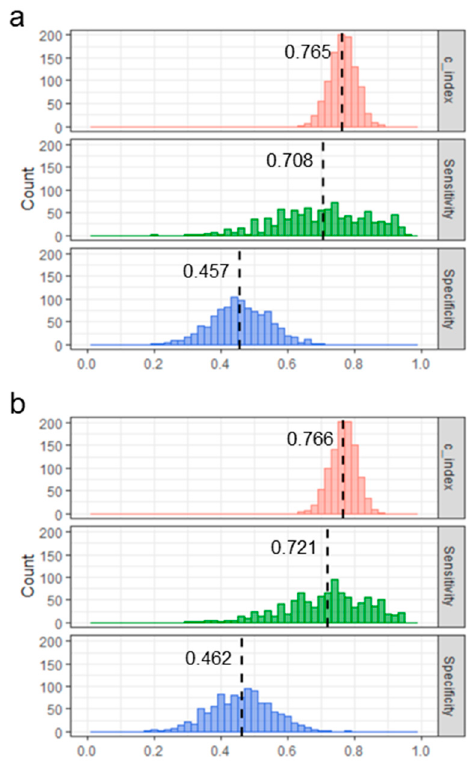
Figure 6. Harrell’s C-index, sensitivity, and specificity obtained from computer simulation. The case of discriminating between patients who would develop HCC within 1 year and those who would develop HCC later or not ( a ). The case of discriminating between patients who would develop HCC within 3 years and those who would develop HCC later or not ( b